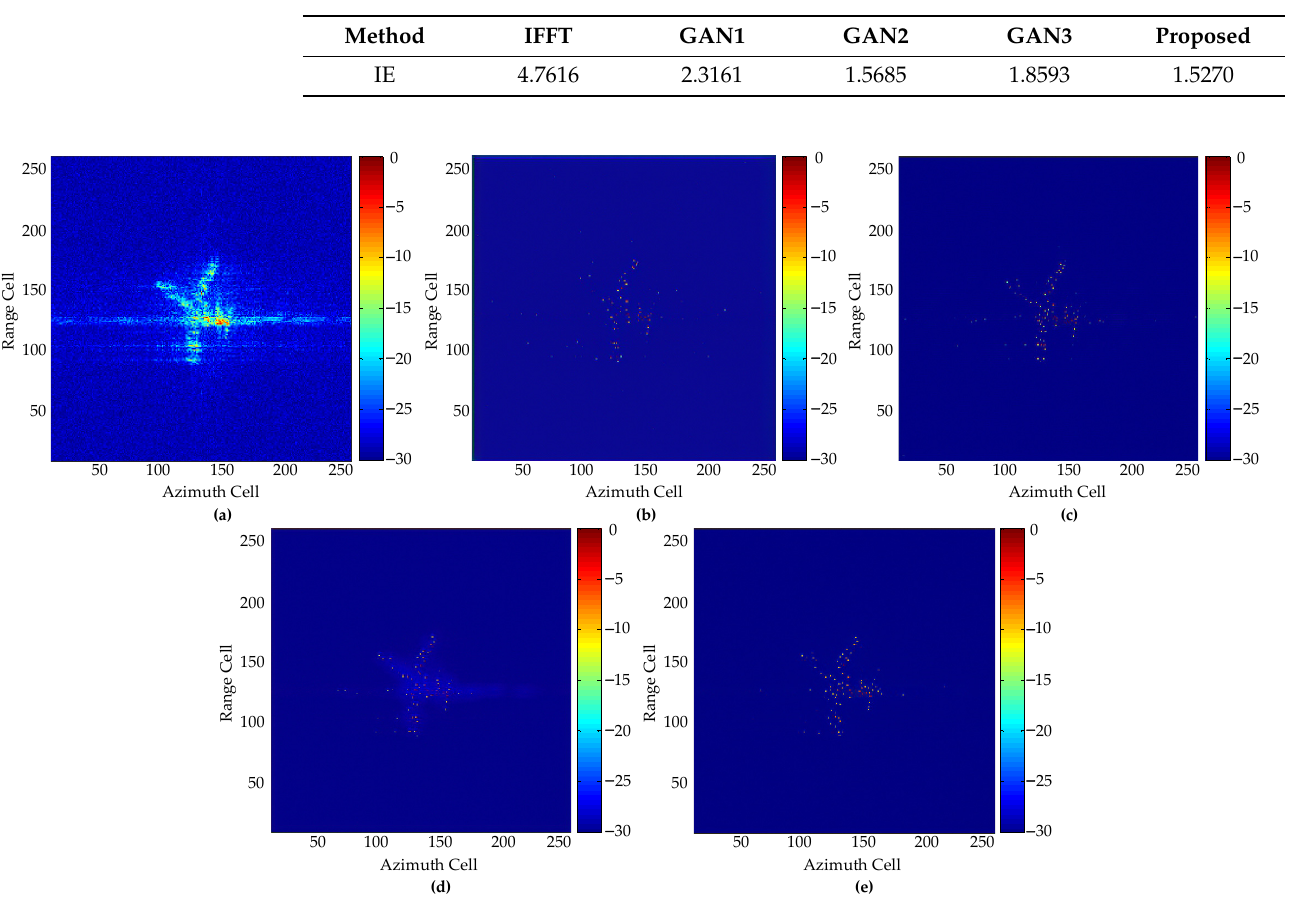
Table 6. Numerical performance evaluation for Yak42 at SNR = − 4 dB.